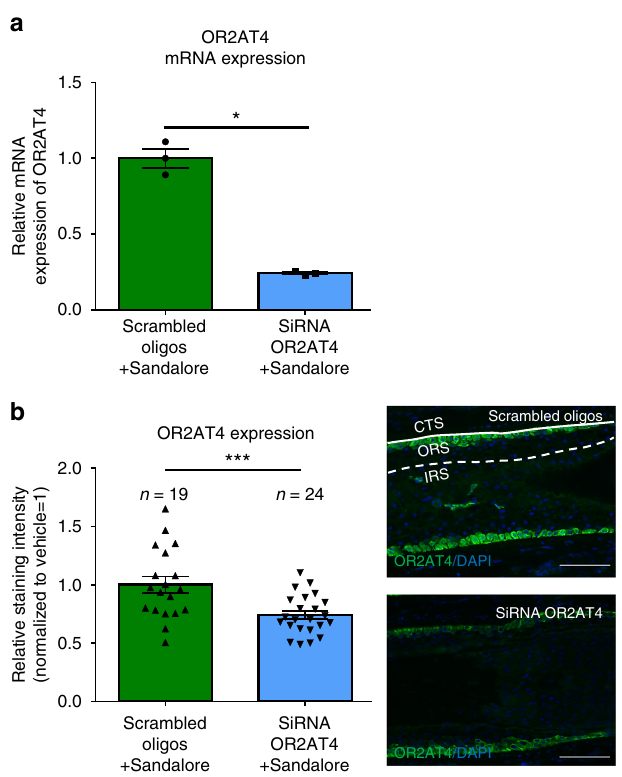
Fig. 4 OR2AT4 expression in Scambled oligos or siRNA OR2AT4 Sandalore ® -treated, microdissected human scalp HFs after 6 h of organ culture. a Microdissected, human scalp HFs were treated for 6 h with OR2AT4 siRNA or scrambled oligos, using the intrafollicular gene silencing technique 32 . OR2AT4 mRNA expression was evaluated after 24 h of culture in siRNA or scrambled oligo-transfected HFs. b OR2AT4 protein expression was evaluated using ImageJ in the ORS of siRNA-treated and control HFs after 6 days of culture. Representative pictures of OR2AT4 expression in the ORS of cultured HFs. Mean± SEM, n = 19 – 24 HFs from three donors (independent experiments), Student ’ s t -test, * P < 0.05, *** P